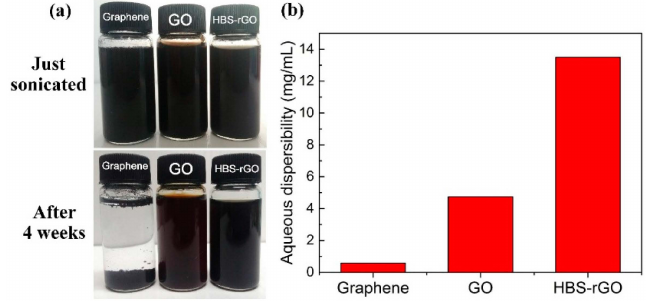
Figure 8. ( a ) Digital images of graphene, GO and HBS-rGO aqueous solutions (1.5 mg/mL) after being kept for four weeks. ( b ) Aqueous dispersibility of graphene, GO and HBS-rGO.